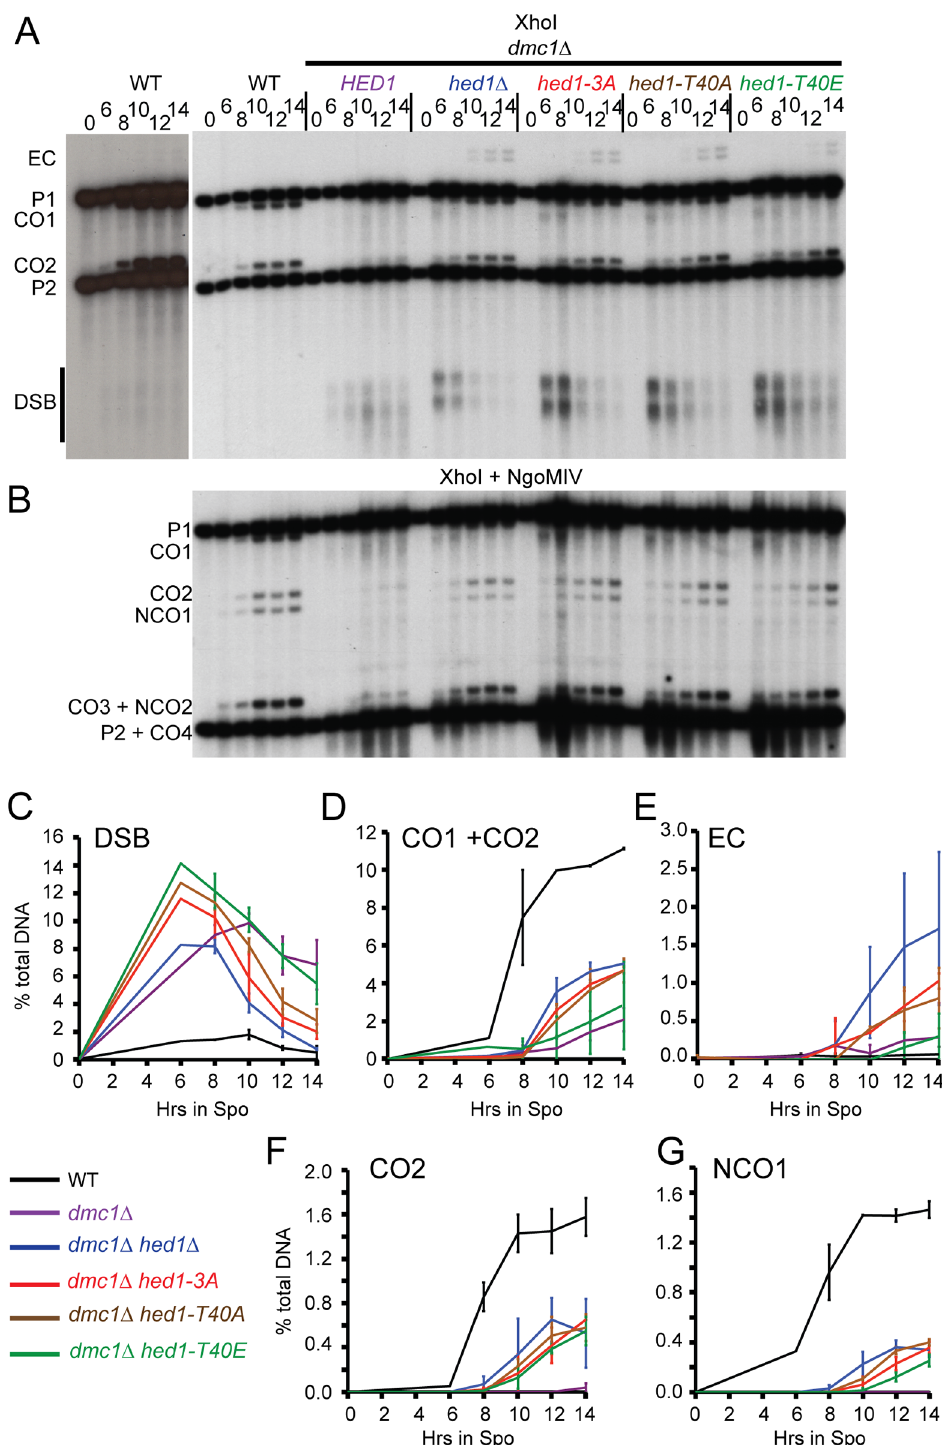
Fig 4. Physical analysis of recombination at the HIS4-LEU2 hotspot. (A) DNA was isolated at the indicated timepoints, digested with XhoI and probed as described in [59] to detect DSBs and COs. For the WT, a darker exposure is shown on the left to show the DSBs. “ EC ” indicates bands resulting from ectopic recombination [42]. (B) DNA from the same time course shown in A was cut with XhoI and NgoMIV to detect CO and NCO recombinants at the HIS4-LEU2 hotspot. (C) Quantification of DSBs from two